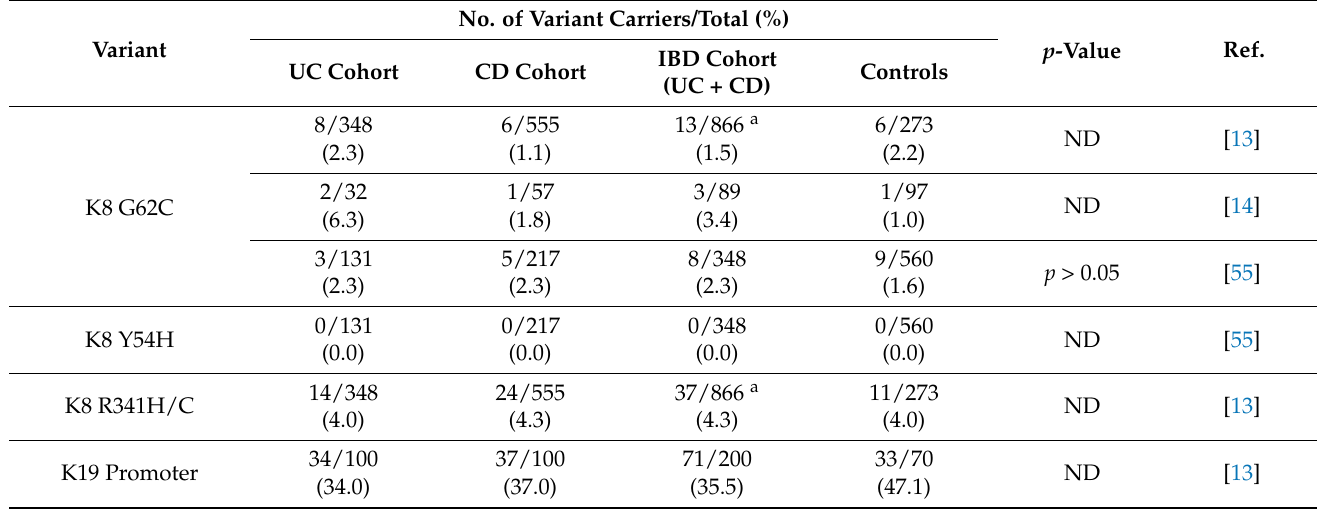
Table 3. Comparison of the keratin variant frequency in patients with IBD and the controls. No. of Variant Carriers/Total (%) Variant